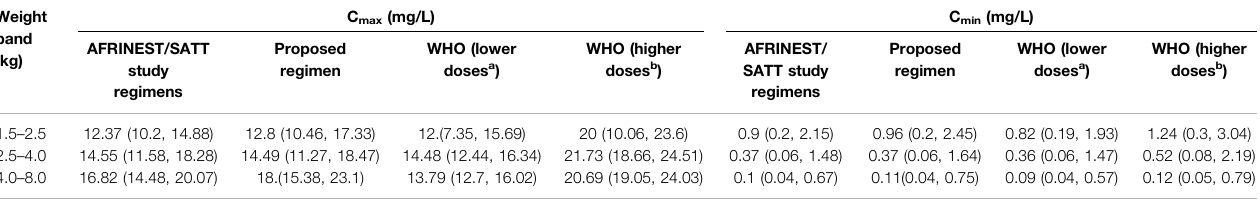
Values shown are the median, 5 th and 95 th percentiles. a Lower doses are 3 mg/kg for low birth weight ( < 2.0 kg) newborns and 5 mg/kg for those with body weight > 2.0 kg. b Higher doses are 4 mg/kg for low birth weight newborns and 7.5 mg/kg for those with body weight > 2.0